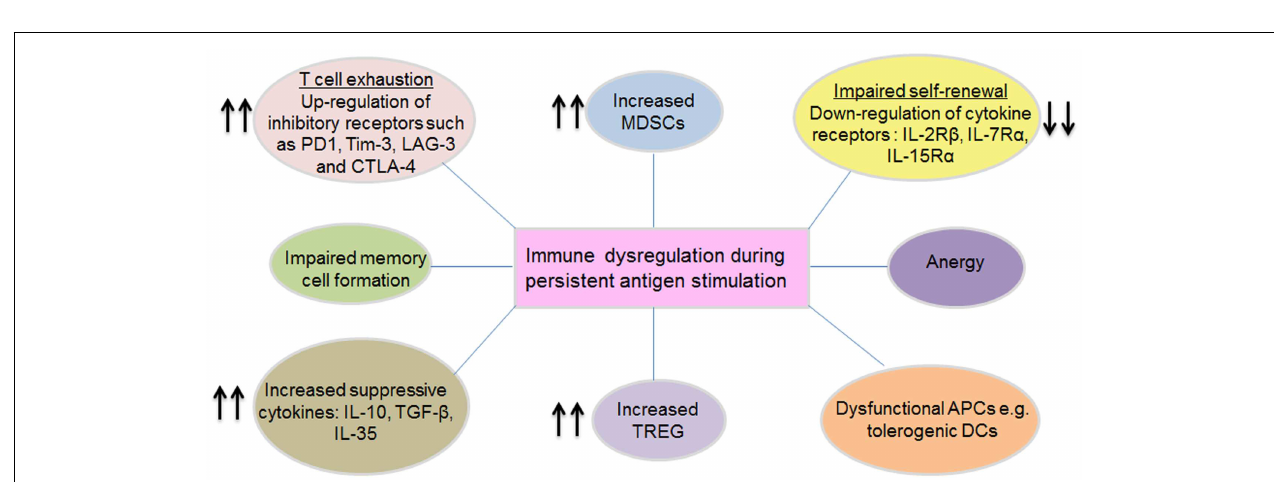
various biochemical pathways that lead to increased frequencies of MDSCs andTreg, which actively suppress effector immune responses via a variety of mechanisms. Immune dysregulation occurring at theT cell priming stage is linked to dysfunctional APCs (for example inadequately activated or tolerogenic DCs), which are likely to skew the immune response toward tolerance. Conceivably, such regulatory mechanisms serve to prevent tissue damage and aberrant immune activation, but they inevitably contribute to the chronic persistence state as a result of inhibiting effector immune